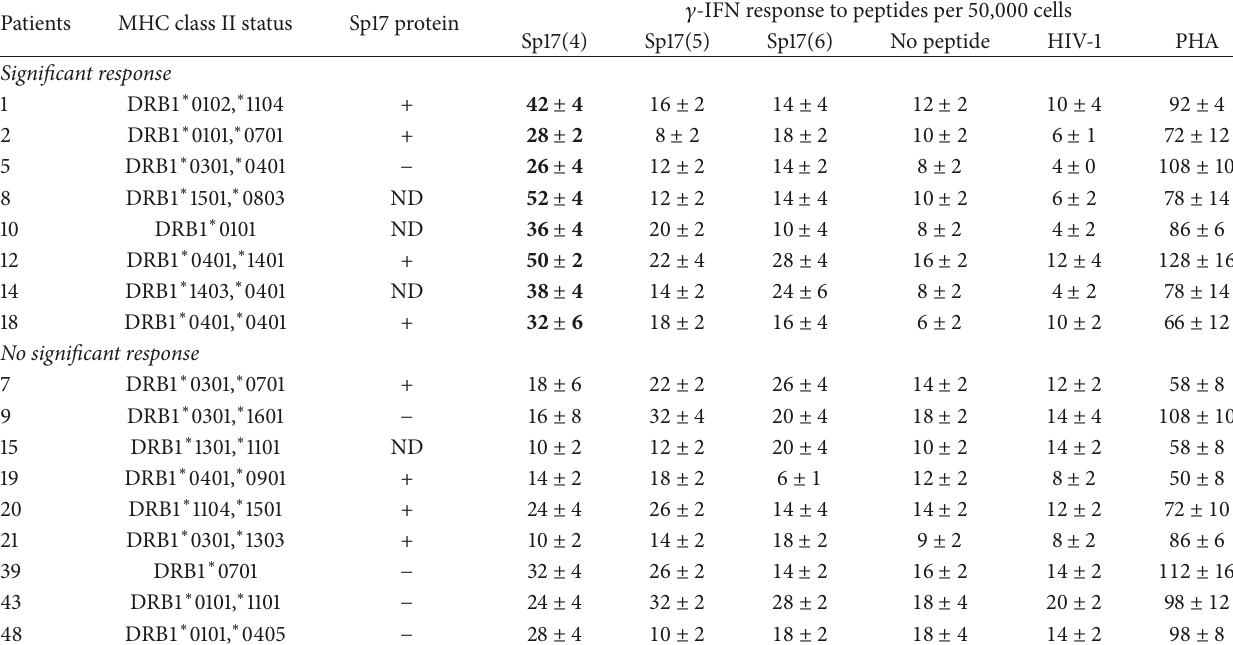
Table 2: Summary of the CD4 T cell responses to the Sp17 peptides by DLBCL patients.